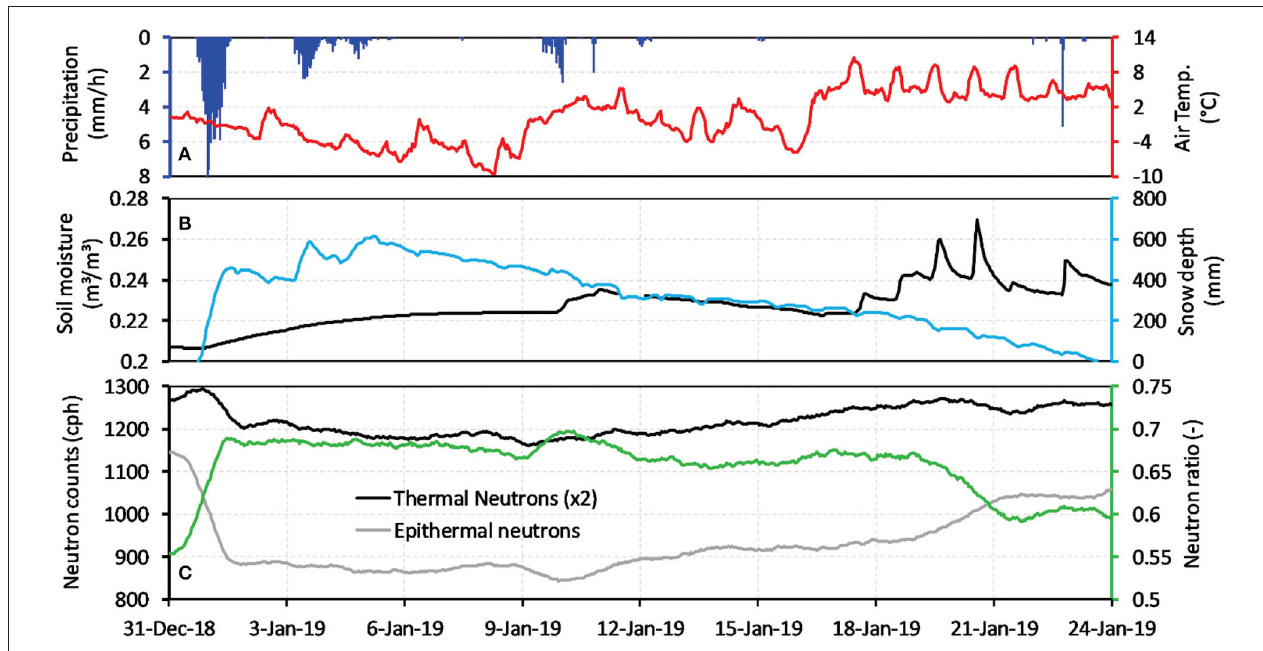
FIGURE 4 | Time series of: (A) precipitation and air temperature, (B) snow depth and vertically and horizontally weighted in-situ soil moisture measured with SoilNet, and (C) epithermal and thermal neutron count rates (24-h moving averages) and the neutron ratio. Note that the thermal neutron intensity is multiplied by two for illustrative